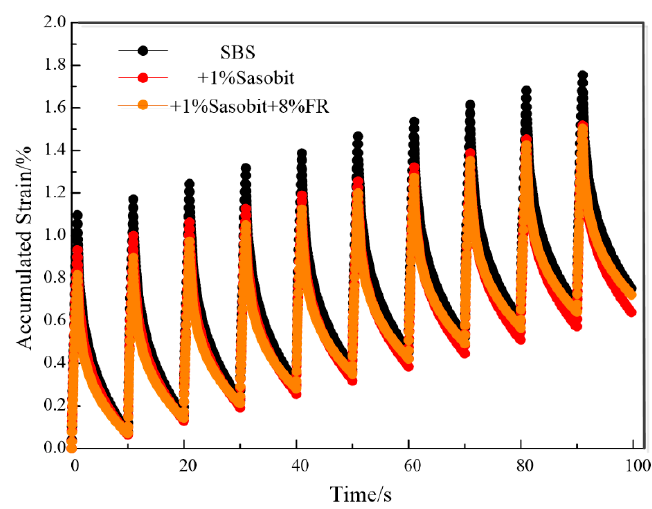
Figure 6. Strain response of asphalt binder at 30 °C.